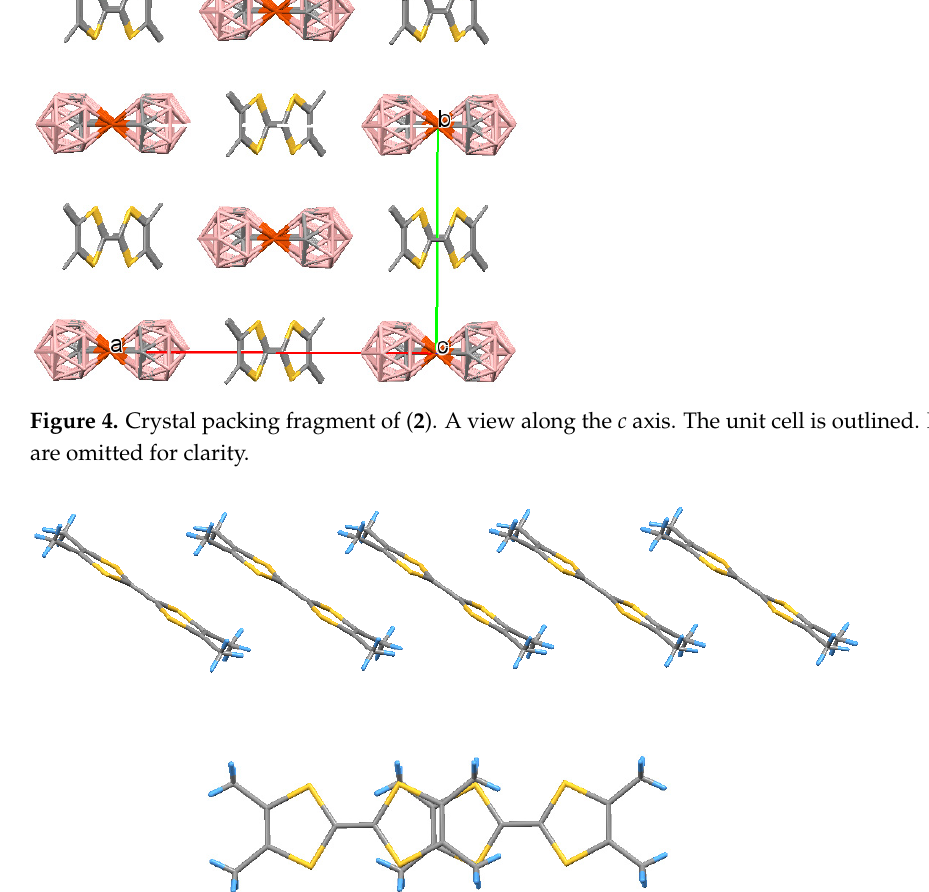
Figure 5. A stack and radical-cations overlapping in ( 2 ).